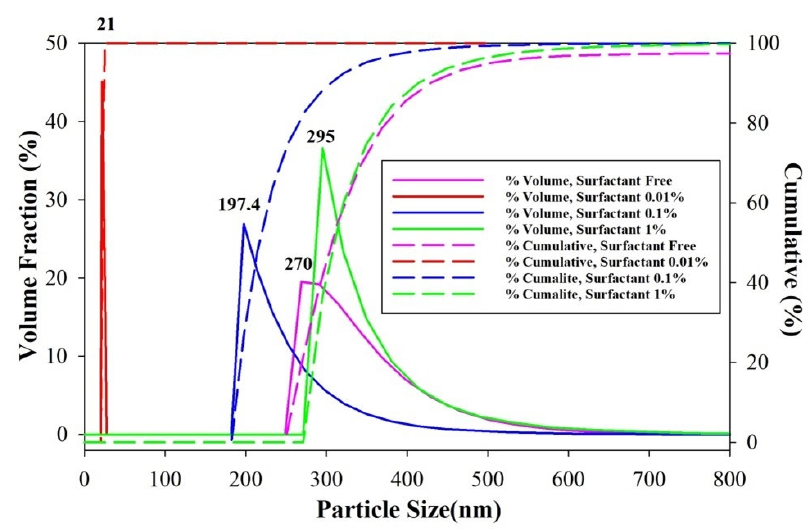
Figure 10. Effect of surfactant concentration on particle size distribution of BaFe 11.2 Mg 0.4 Al 0.4 O 19 .